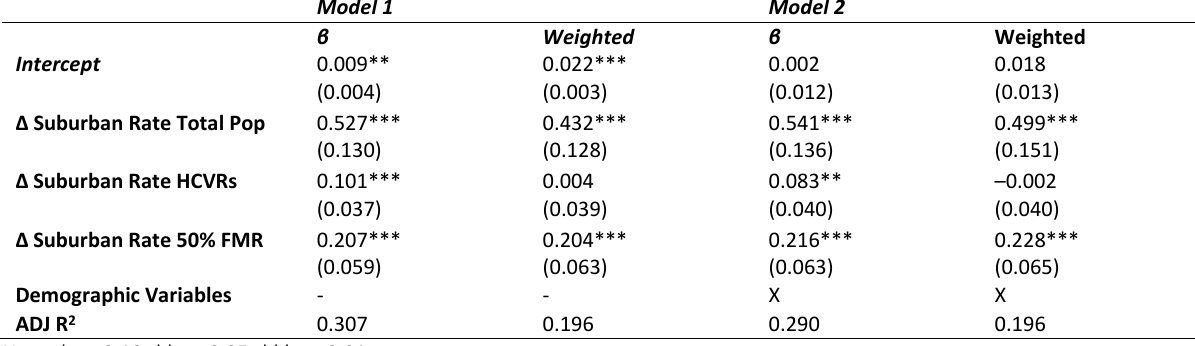
Table 2. 1st difference multivariate regression of suburban share poor 2000–2008 (N =